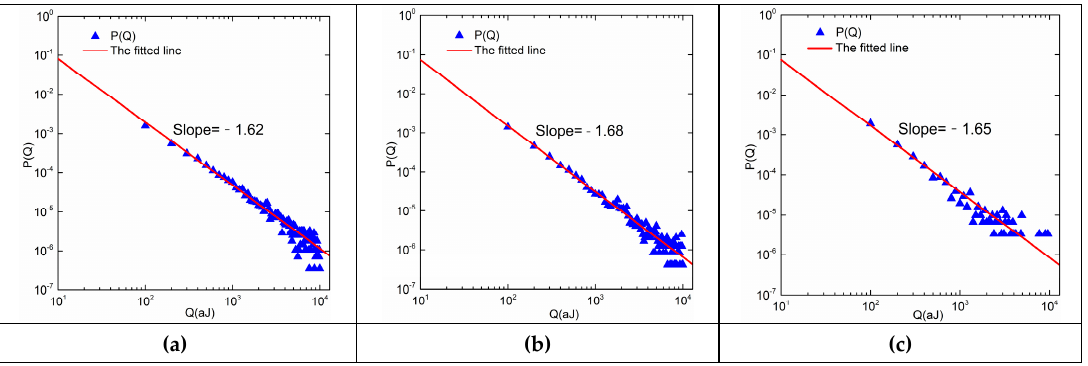
Figure 8. Log–log plots of the energy distribution of the AE events: ( a ) B-30, ( b ) B-45, ( c ) B-60.